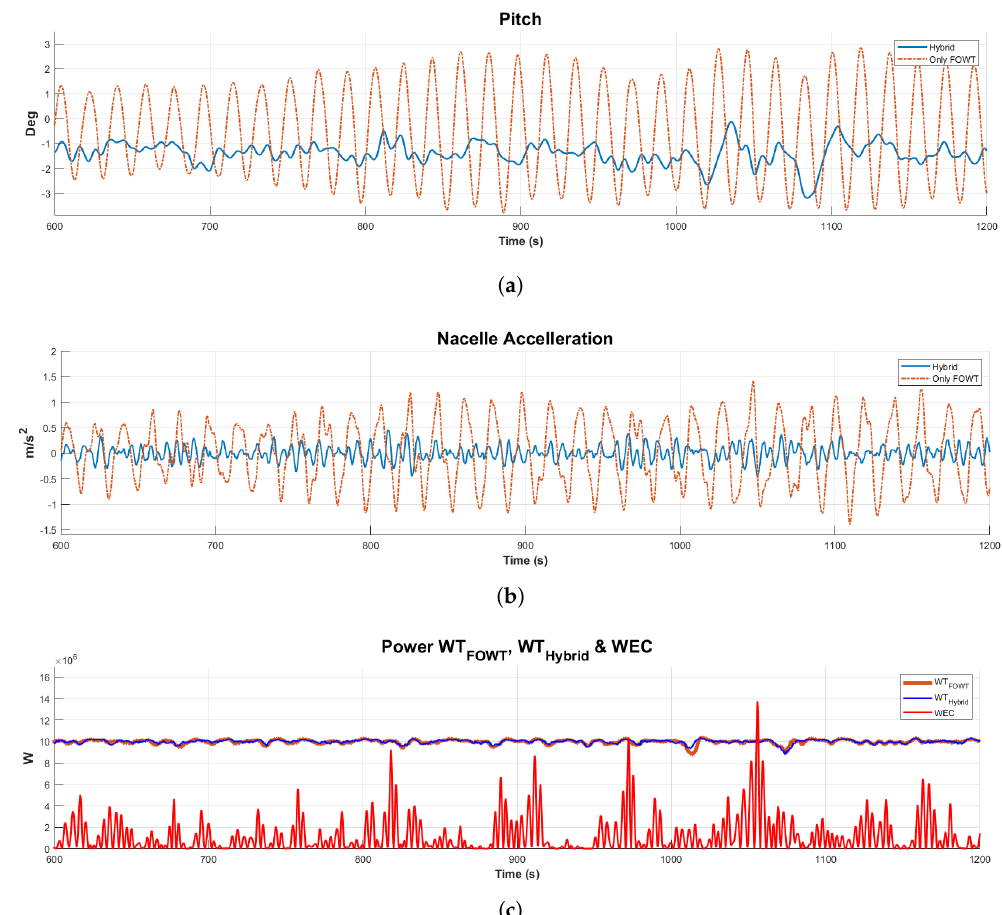
Figure 21. Pitch ( a ), Nacelle acceleration ( b ) and power output ( c ) comparison with H s = 4 m; T p = 10 s; V 0 = 14 m/s of Hybrid and only FOWT system.